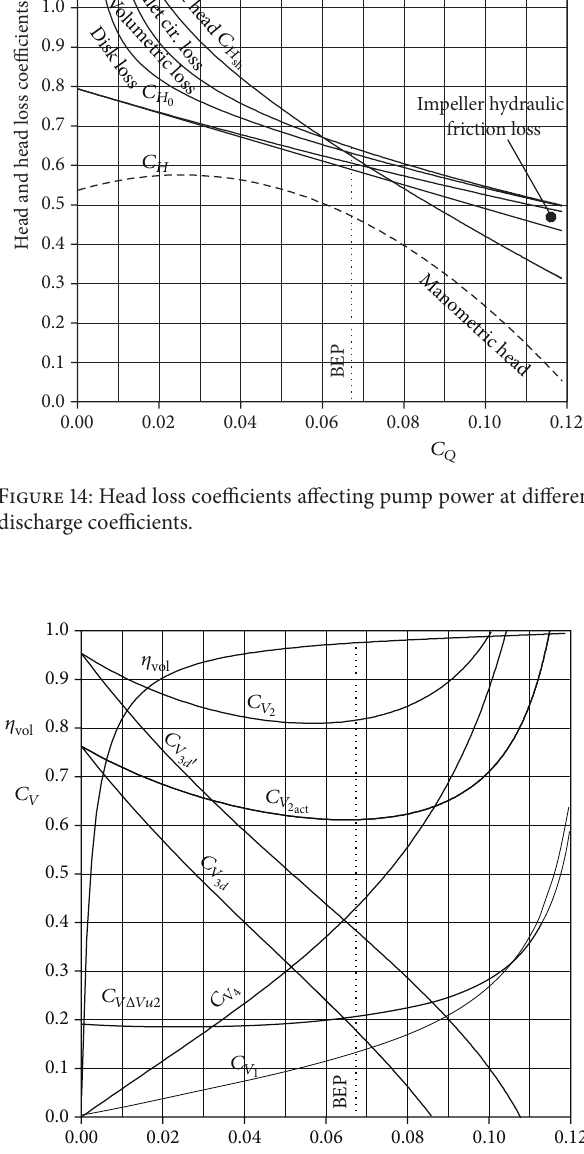
Figure 17: Effect of pumped fluid viscosity on the performance of centrifugal